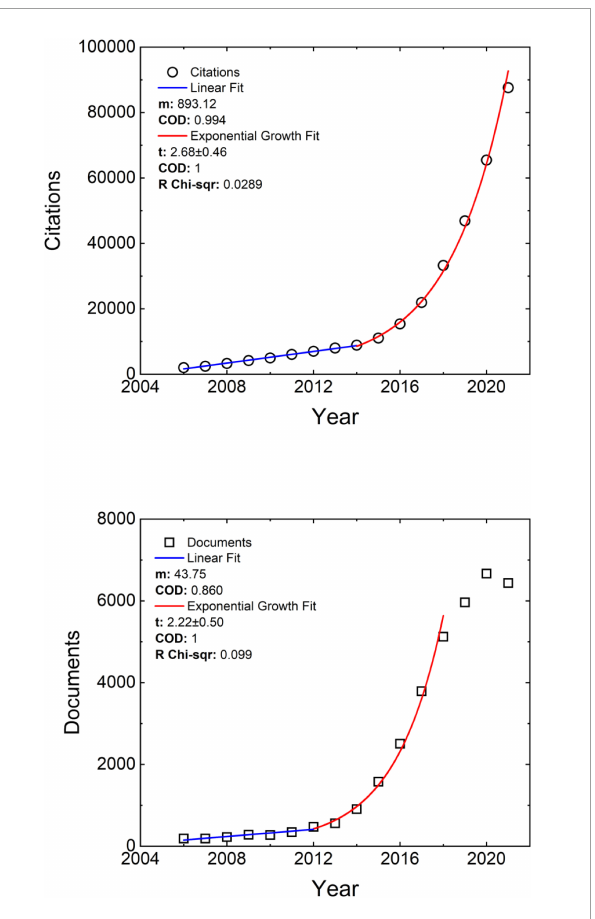
FIGURE1 Number of documents published (Left) and citations recorded per year (Right) for all the Ecuadorian